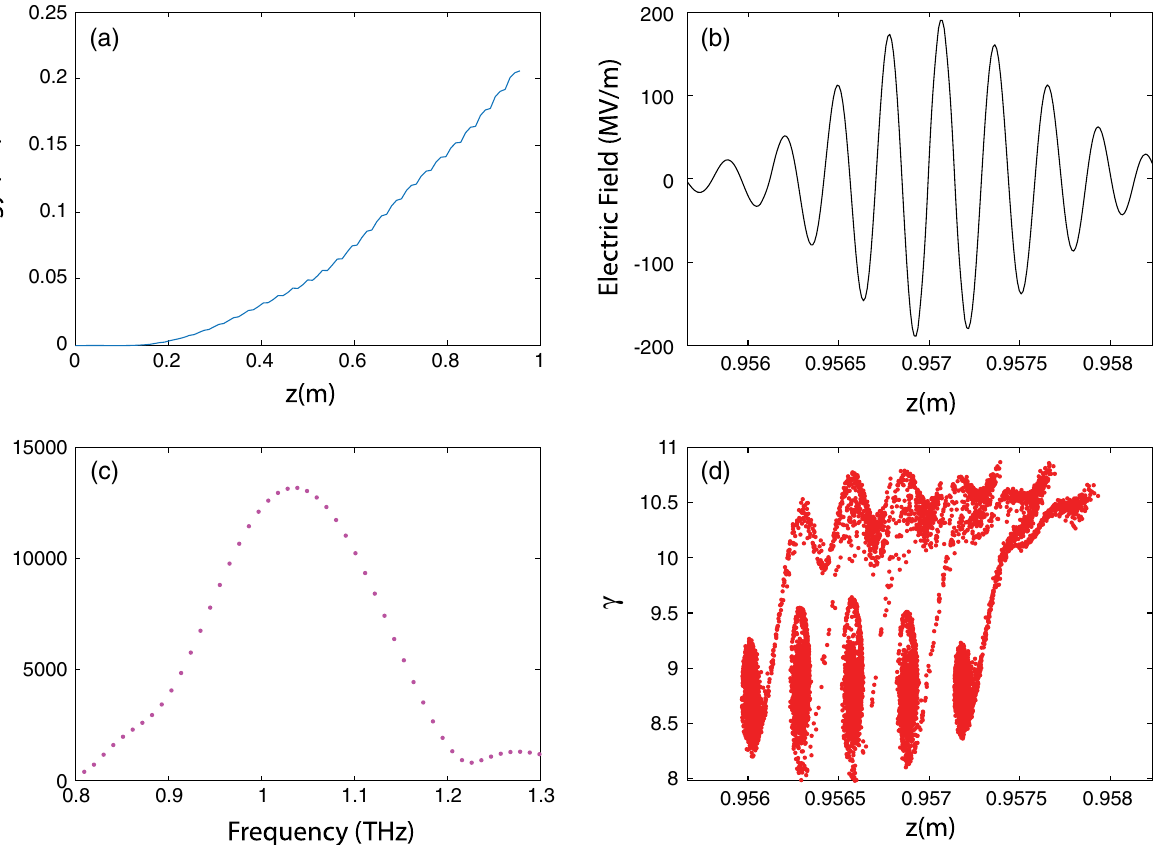
FIG. 10. (a) THz pulse energy along the undulator. (b) THz waveform at the undulator exit. (c) THz spectrum. (d) Longitudinal phase space of electron beam.